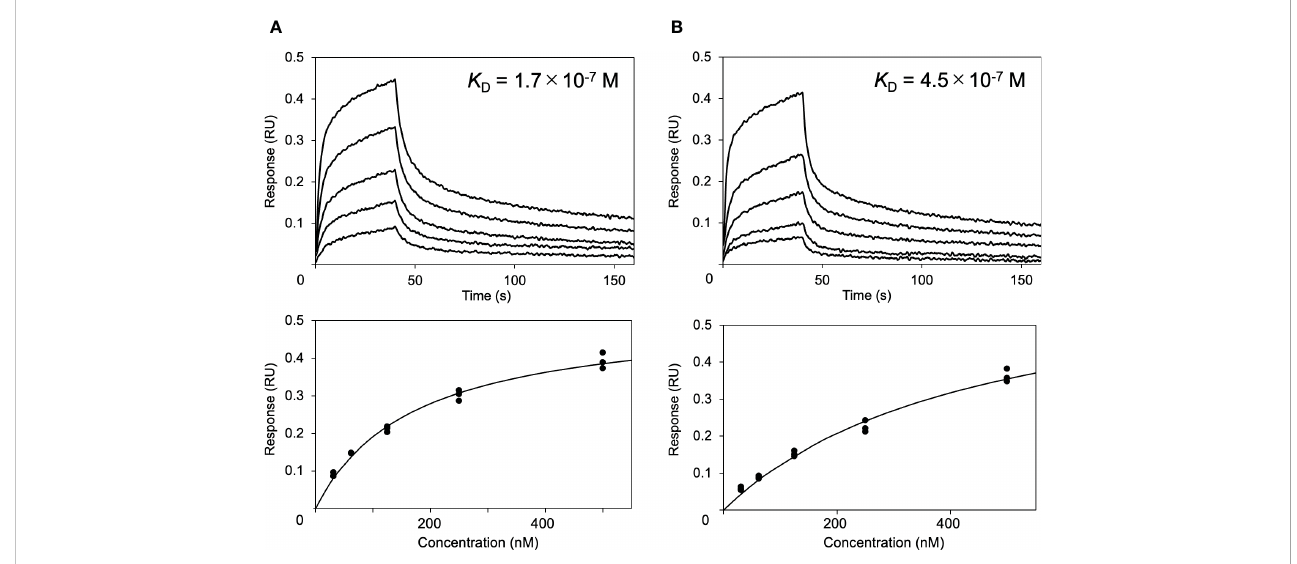
FIGURE 2 Effect of HSA on the interaction between rituximab and Fc g RIIIa. Interaction of rituximab with the immobilized form of the extracellular region of human Fc g RIIIa was observed by BLI in the (A) absence or (B) presence of